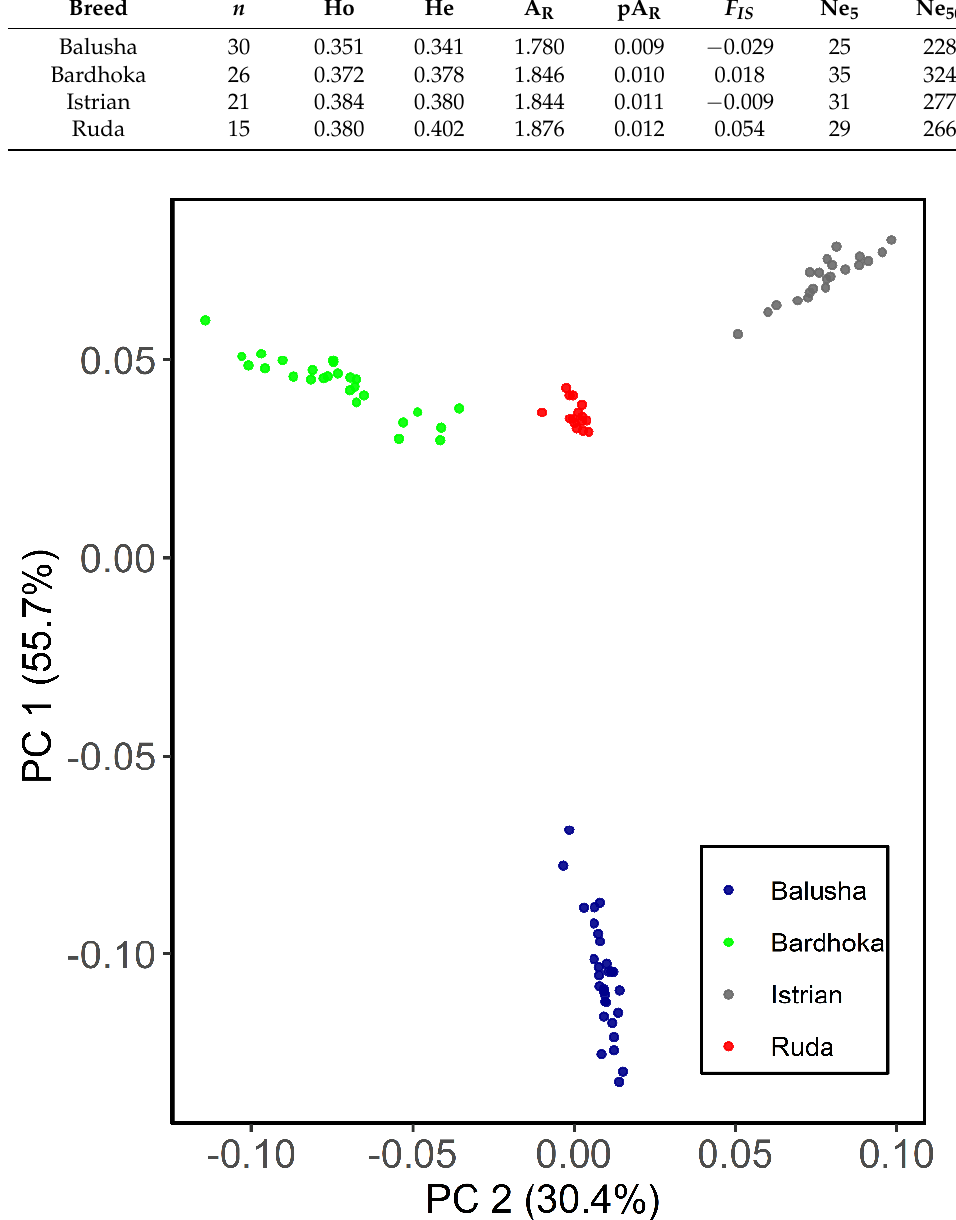
Figure 2. Principal component analysis plot for the first (PC1) and second (PC2) components of Balusha, Bardhoka, Istrian and Ruda sheep breeds. The different breeds are color-coded as mentioned in the legend. Note that the blue Balusha cluster is clearly separated from the rest of the breeds.